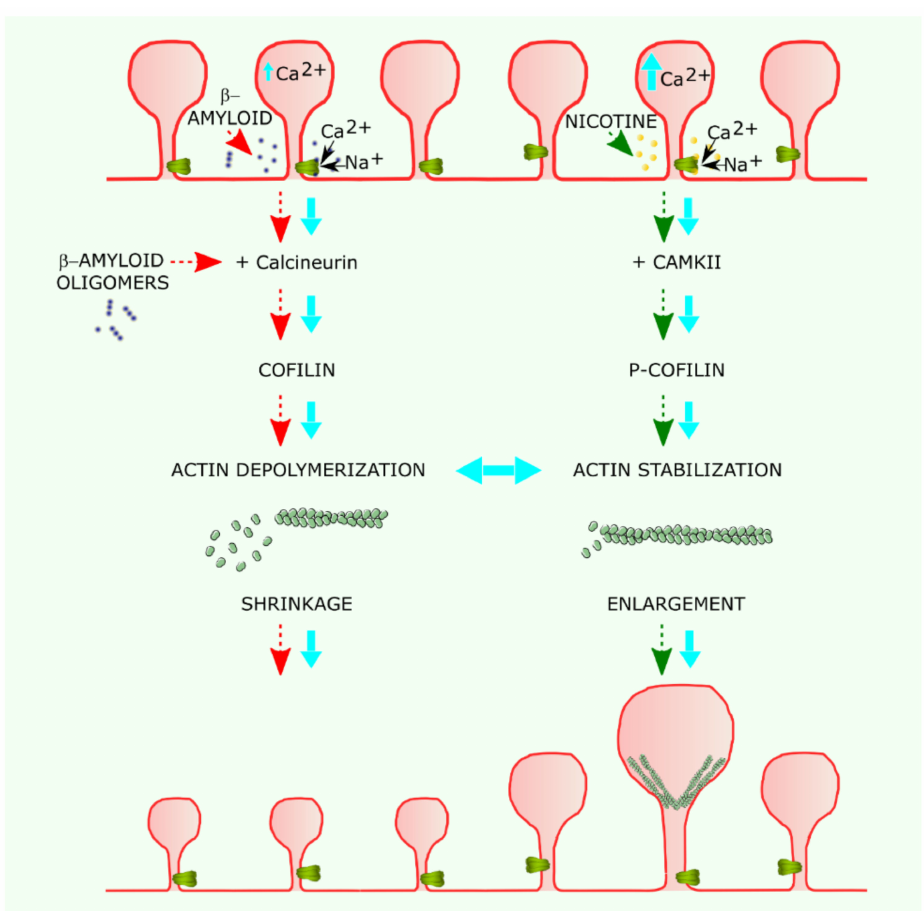
Figure 2. Possible mechanism of α 7 nAChR modulation of dendritic spine morphology and its alteration in Alzheimer disease. The vertical flow diagram on the left shows the pathological cascade, in which β -amyloid oligomers activate α 7 nAChR and the calcineurin–cofilin pathway. The increase in intracellular calcium concentration reinforces calcineurin activation. Activated calcineurin dephosphorylates cofilin, which, in turn, depolymerizes actin filaments, leading to spine shrinkage and dysmorphism. Diffusion of cofilin to neighboring spines acts like a chain reaction, spreading the shrinkage along the dendrite. The flow diagram on the right illustrates the protective action of nicotine, which activates α 7 nAChRs leading to intracellular calcium increases that activate CAMKII, which, in turn, leads to phosphorylated cofilin (p-cofilin), stabilizing actin filaments. The polymerization and stabilization of actin filaments is associated with spine